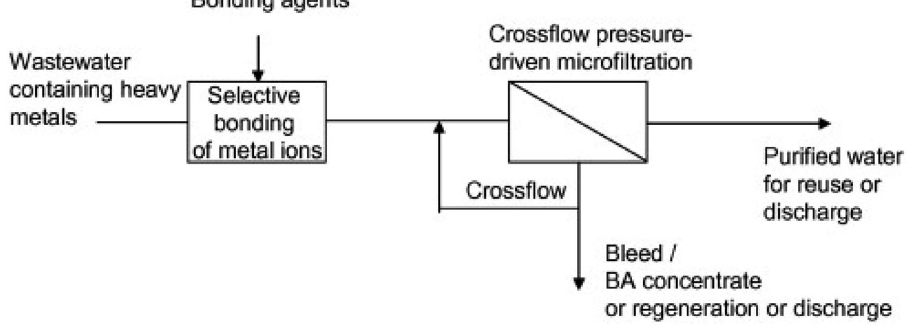
Fig. 6 The integrated processes combining metal bonding and separation by a new hybrid pro- cess (for highly contaminated